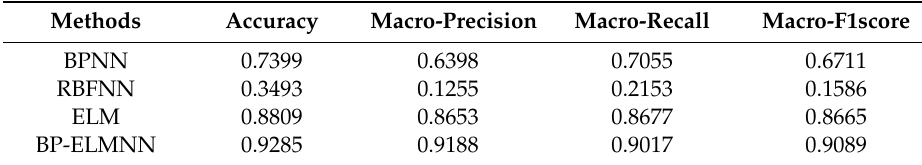
Table 6. The accuracy, macro-precision, macro-recall, and macro-F1 score of the four methods for the OTE.